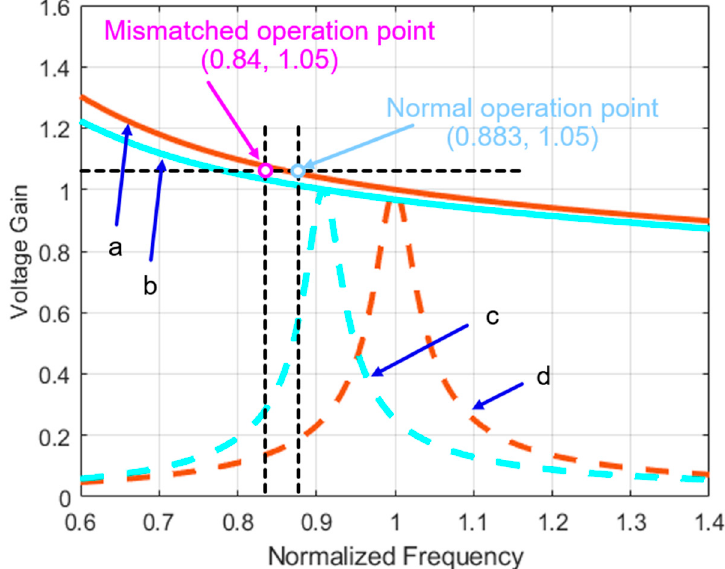
Figure 6. Voltage gain curves during the positive and negative cycles, curve a : Nominal Q -value condition with the matched leakage inductance L lk, 2 n at the secondary side; curve b : Nominal Q -value condition with the mismatched leakage inductance L lk, 2, neg at the secondary side during the negative cycle; curve c : High Q -value condition with the matched leakage inductance L lk, 2 n at the secondary side; curve d : High Q -value condition with the mismatched leakage inductance L lk, 2, neg at the secondary side during the negative cycle.